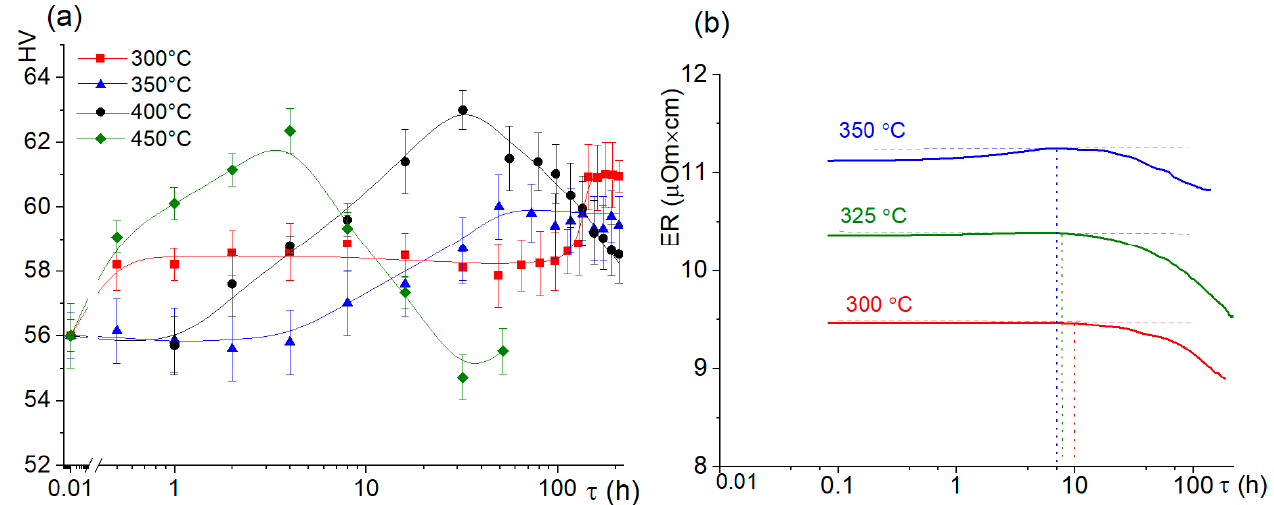
Figure 3. ( a ) The hardness and ( b ) electrical resistance evolution vs. annealing time for the as-cast Al-2%Cu-2%Mn alloy.